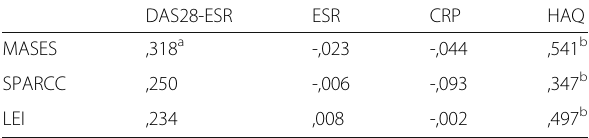
Table 3 Correlation of the enthesitis indices with disease activity and function in 59 patients with peripheral SpA DAS28-ESR ESR CRP HAQ MASES ,318 a -,023 -,044 ,541 b SPARCC ,250 -,006 -,093 ,234 ,008 -,002